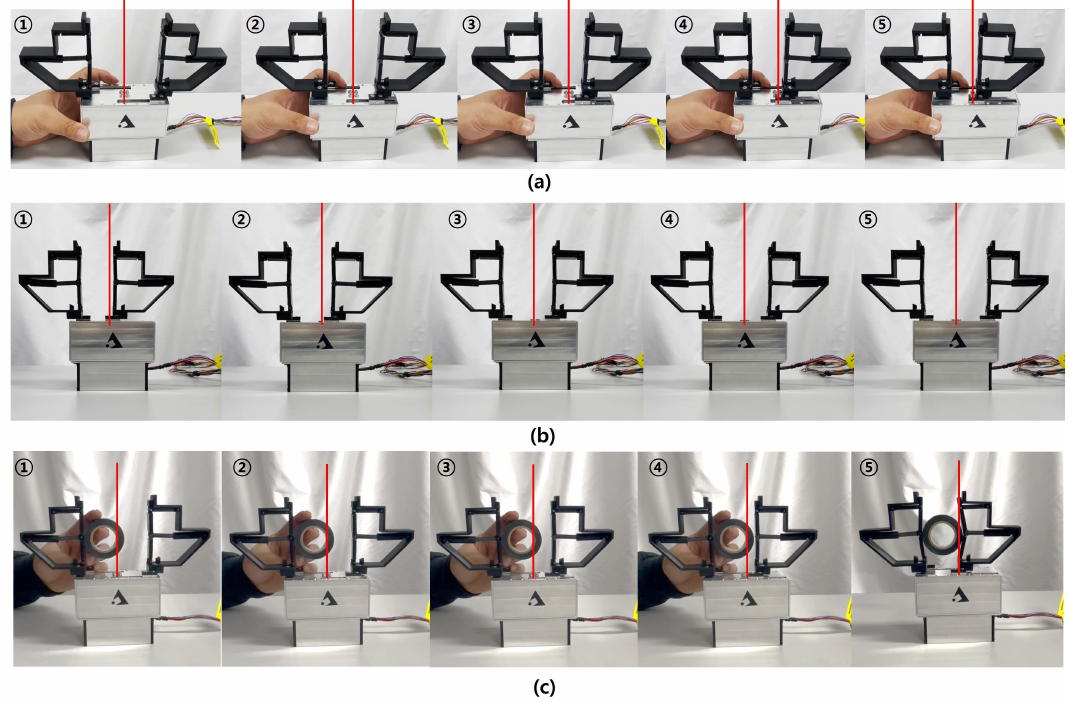
Figure 11. Experimental tests for adaptability in the parallel grasping. ( a ) Jammed situation (With the left finger being fixed, the right gripper finger completes the grasp); ( b ) Recovery to home position (Fingers return to home position from asymmetric grasping); ( c ) Load and shape adaptive grasping (With the left finger being fixed, the right finger completes the encompassing grasp of a circular object of φ = 54 mm and weight 36